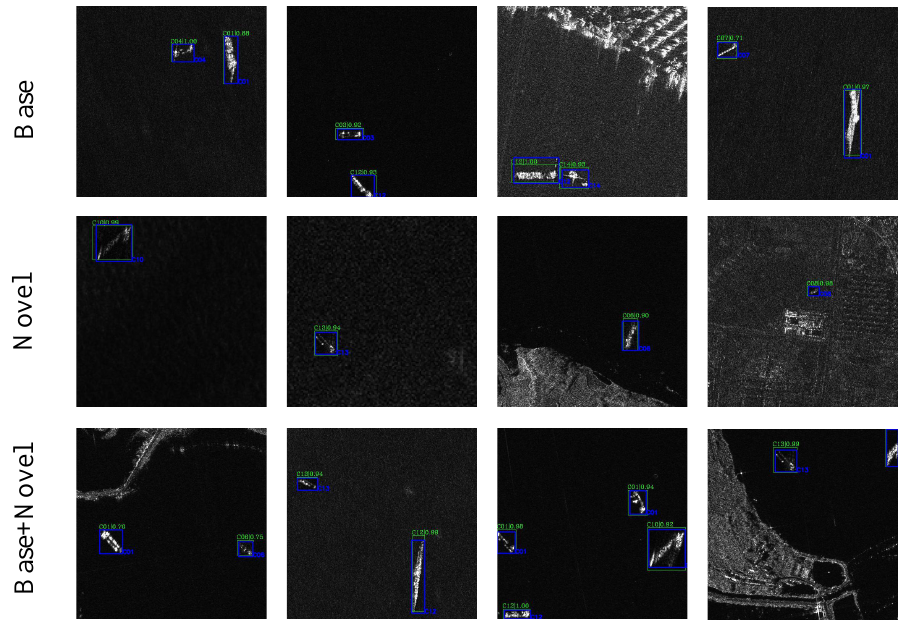
Figure 8. Visualization of detection results on base, novel, and base+novel classes. The blue and green boxes denote the ground truth and detection results with confidence scores, respectively.